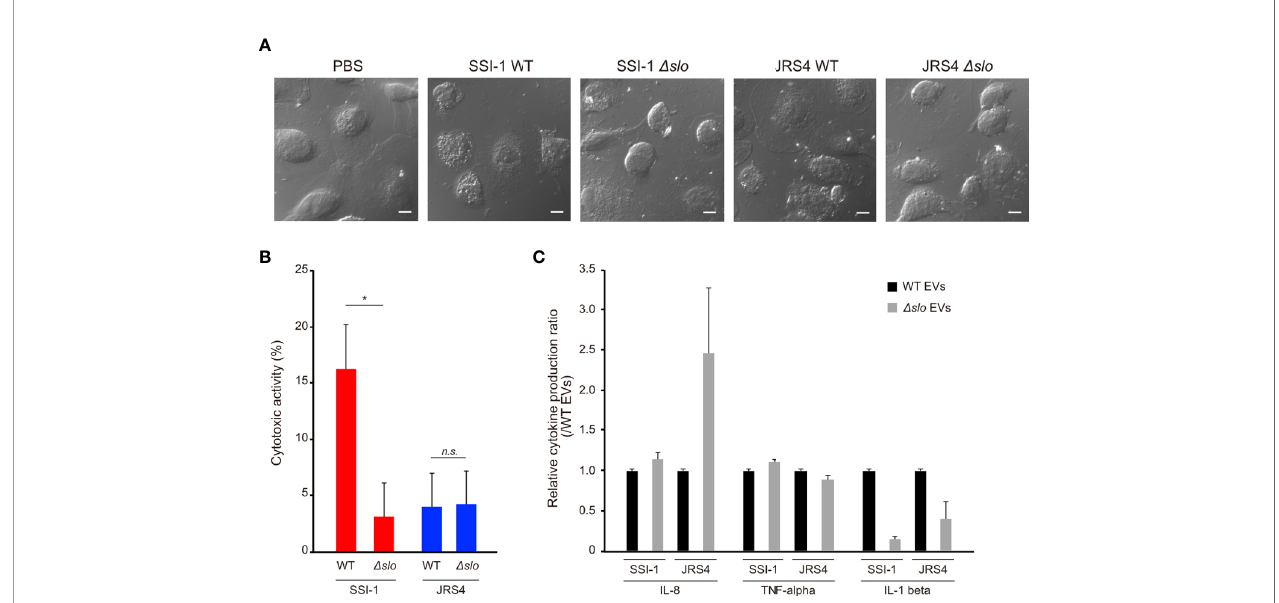
FIGURE 6 | Induction of cytotoxic activity and cytokine expression in dTHP-1 cells by EVs-mediated SLO. The dTHP-1 cells were co-incubated with 10 µg of DiI- labled EVs isolated from two GAS wild-type (WT) and the slo mutants ( Δ slo ) and incubated for 4 h at 37 °C. After incubation period, the cells were observed by confocal microscopy (A) , and the supernatants were used for cytotoxic activity assay (B) and cytokine production assay (C) . Scale bar, 5 µm. All experiments were performed in triplicate and data in B and C represent the mean ± SEM of independent experiments. P-values calculated by two-tailed Student ’ s t-test. *P<0.05; ns, not signi fi cant.